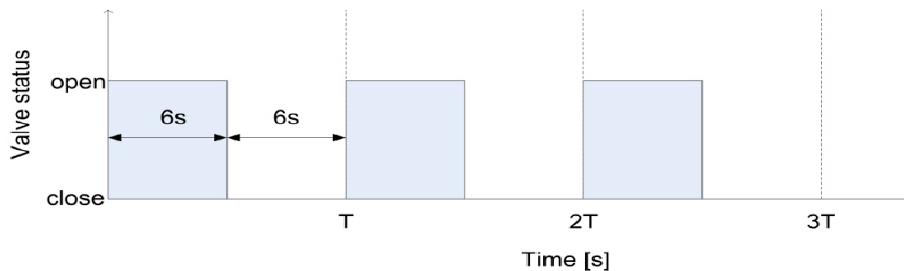
Figure 15. Electrovalve opening and closing to modify the flow conditions.